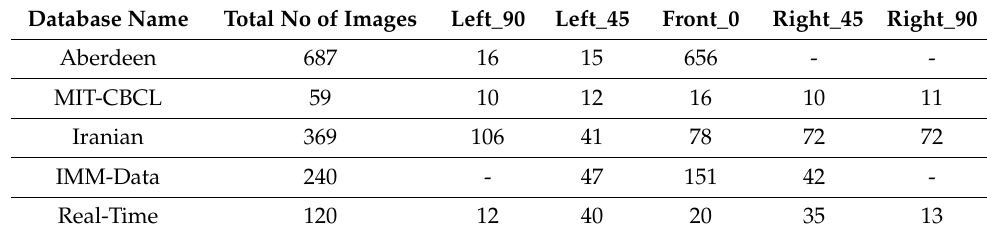
Table 2. Pose information on each